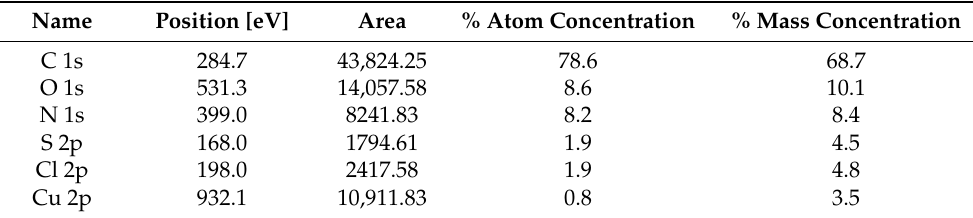
Table 8. The elemental composition determined for Dowex M 4195 after the sorption of Cu(II).